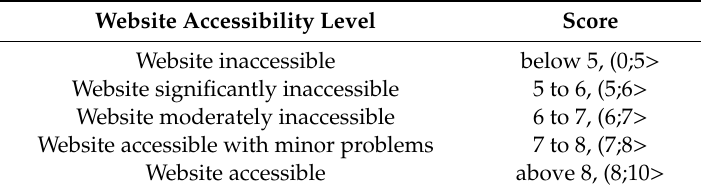
Table 2. Website accessibility level according to